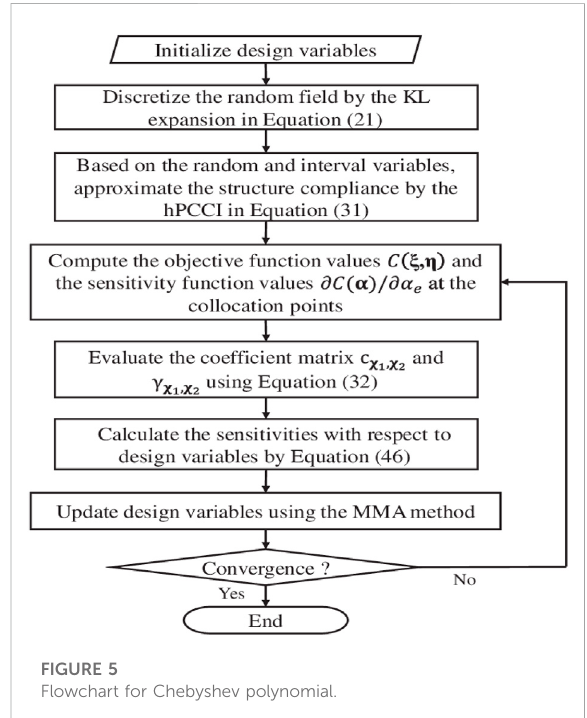
FIGURE 5 Flowchart for Chebyshev polynomial.